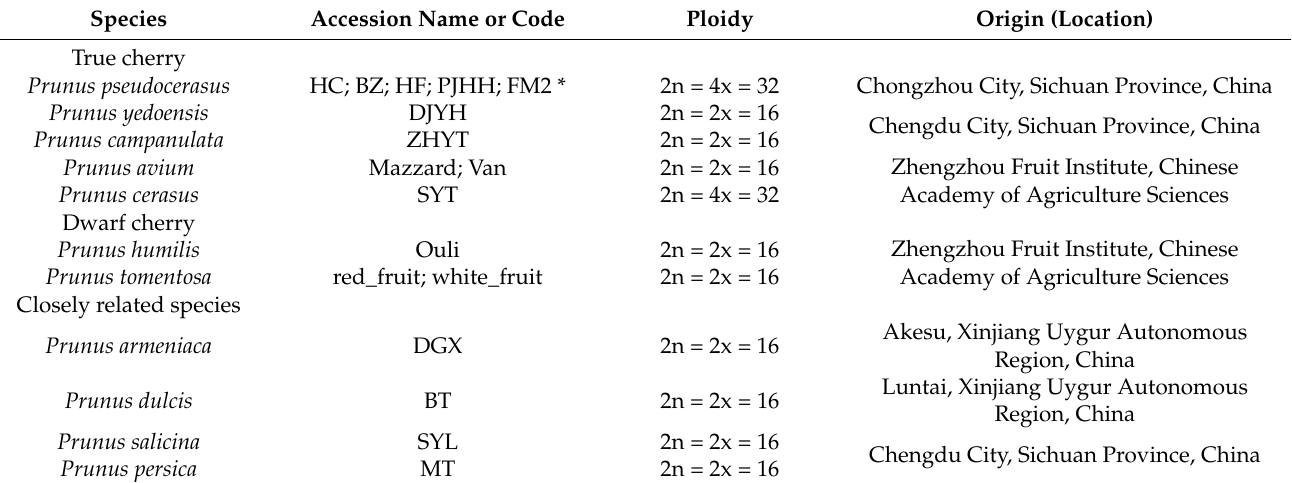
Table 2. Plant materials used in this study for oligo-FISH on mitotic metaphase